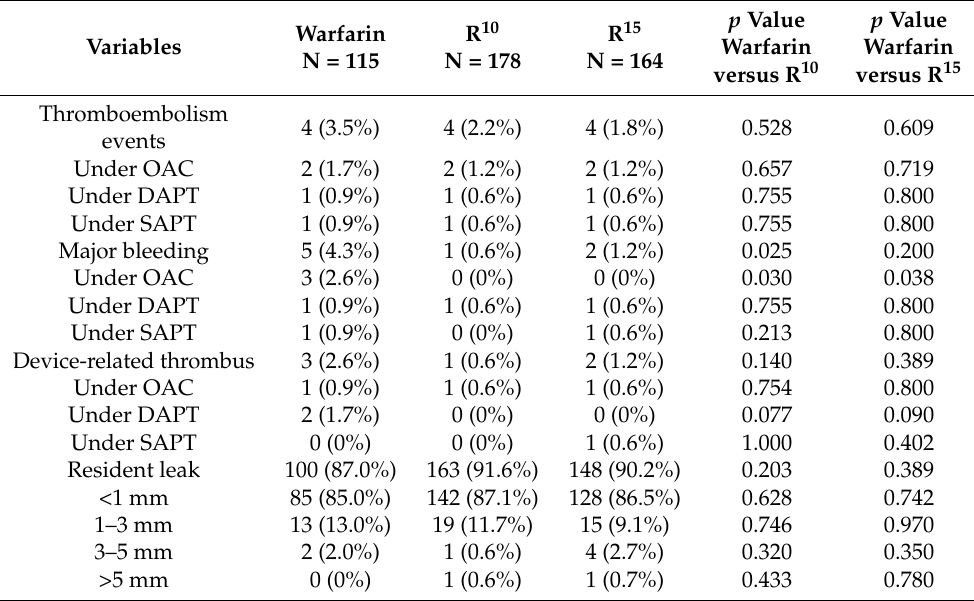
Table 4. Clinical outcomes in patients stratified by warfarin, reduced-dose rivaroxaban, and half- dose